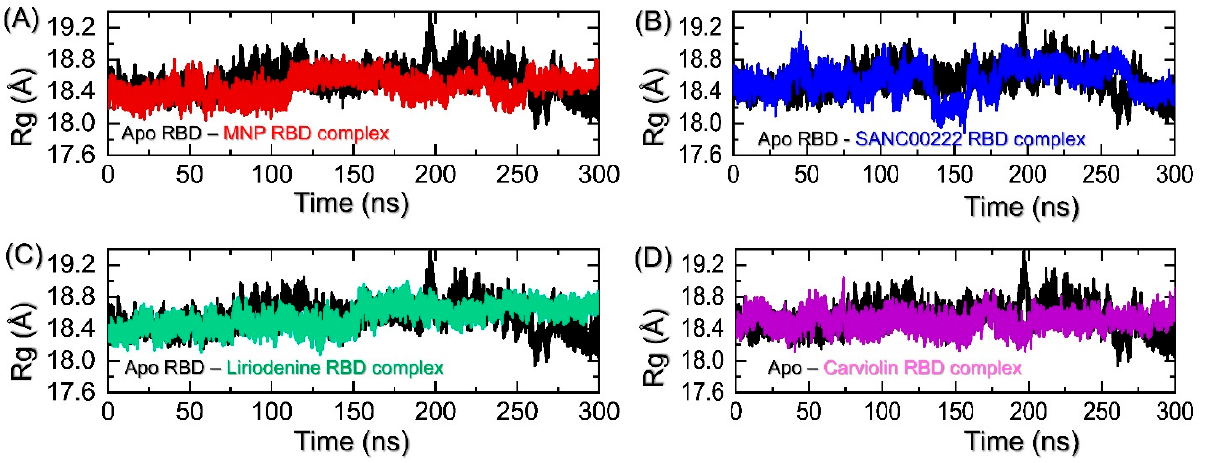
Figure 6. Determination of structural packing in a dynamic environment for the apo-RBD and top complexes. ( A ) shows the R g patterns for apo-RBD and MNP-RBD complex ( B ) shows the R g patterns for apo-RBD and SANC00222RBD complex, ( C ) shows the R g graphs for apo-RBD and Liriodenine-RBD complex, while ( D ) represents the R g graphs for apo-RBD and Carviolin-RBD complex over the course of the 300 ns simulation time.